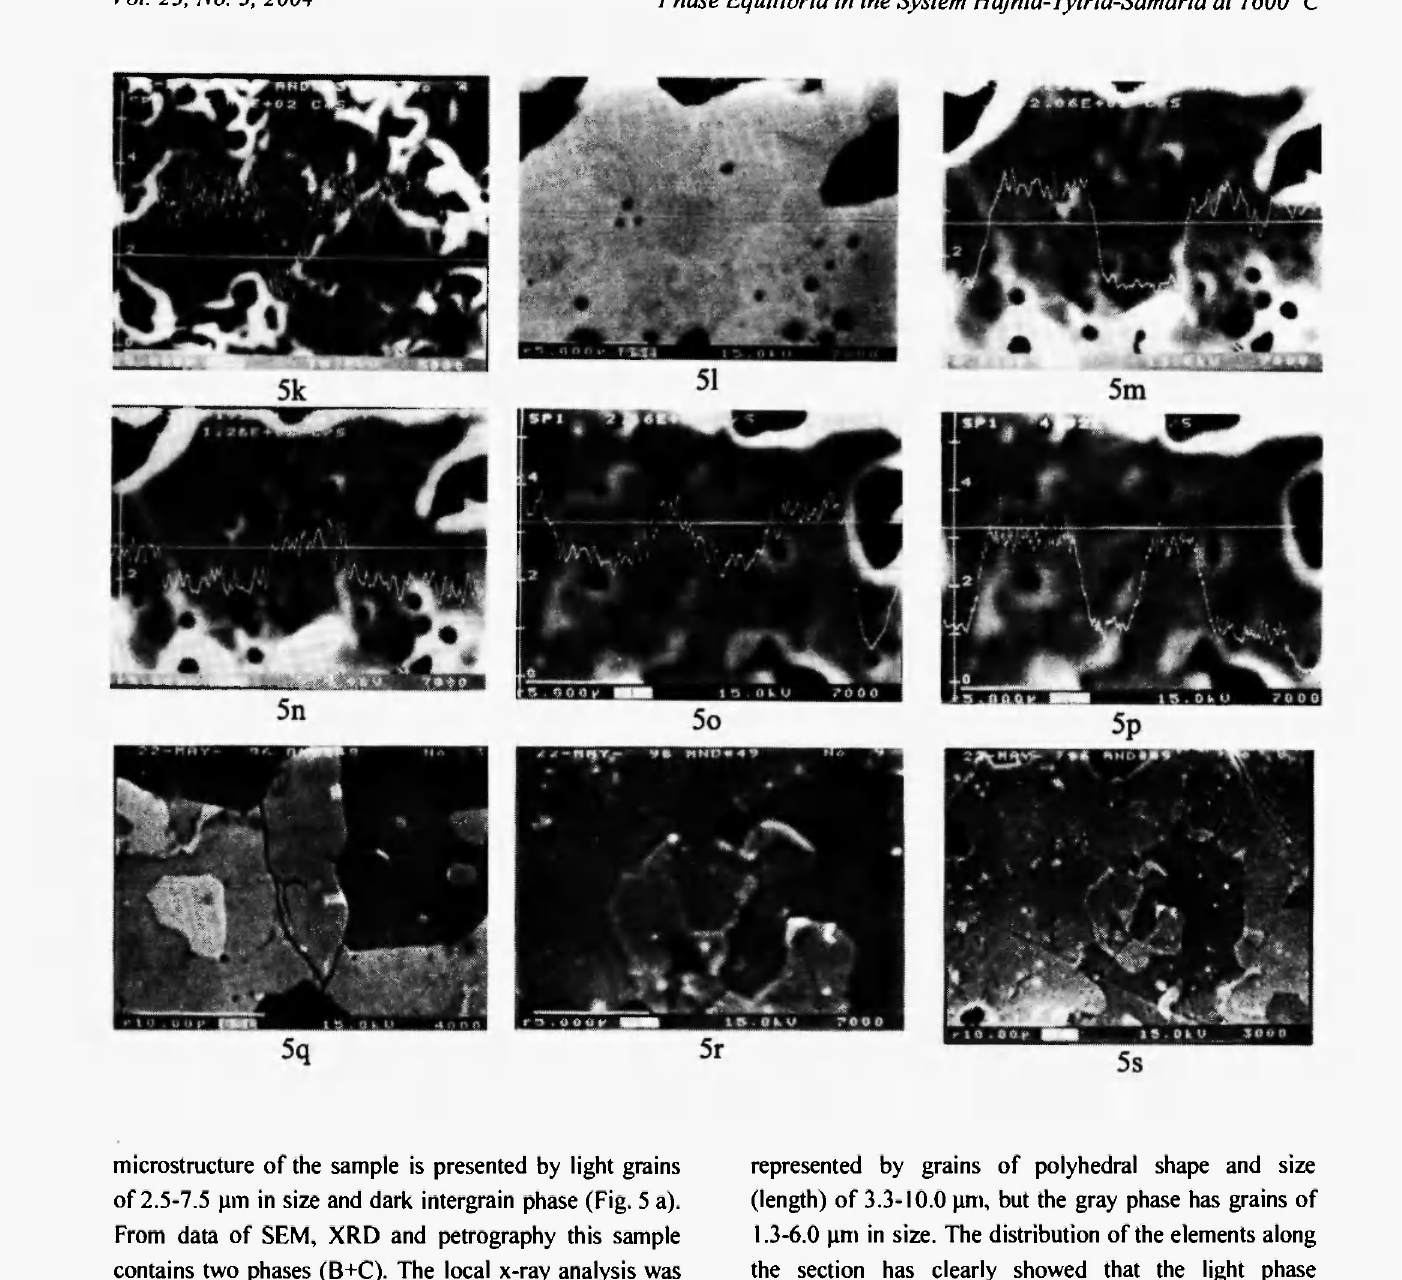
represented by grains of polyhedral shape and size (length) of 3.3-10.0 μπι, but the gray phase has grains of 1.3-6.0 μπι in size. The distribution of the elements along the section has clearly showed that the light phase contains more hafnia while the gray phase is enriched with yttria. Therefore, the light phase is cubic solid solution of F-HfD 2 , and the gray one is the solid solution based on C-Y 2 0 3